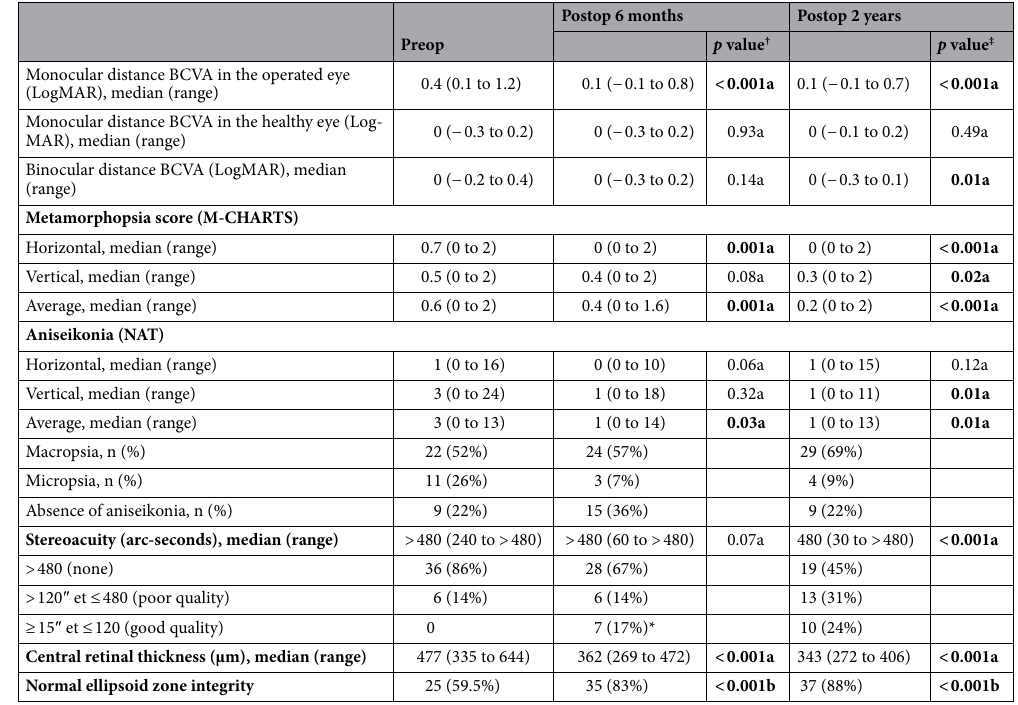
Table 1. Clinical and paraclinical parameters prior to surgery, at 6 months and 2 years postoperatively. BCVA best-corrected visual acuity, NAT New Aniseikonia Test, TNO The Netherlands Organization for applied scientific research. † p value between Preop and 6 months Postop; ‡ p value between Preop and 2 years Postop; In bold : statistically significant difference ( p < 0.05); a Wilcoxon signed-rank test; b McNemar test; *1 TNO data missing at 6 months